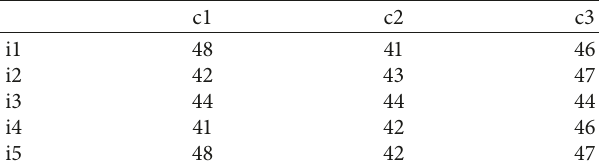
Table 5: Cost of supply of relief goods before the disaster.